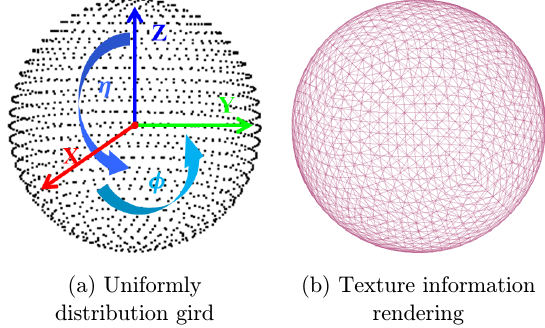
Fig. 2. Gird distribution model of three-dimensional spiral CT Fig. 2. The distribution matrix of pixel sequence of